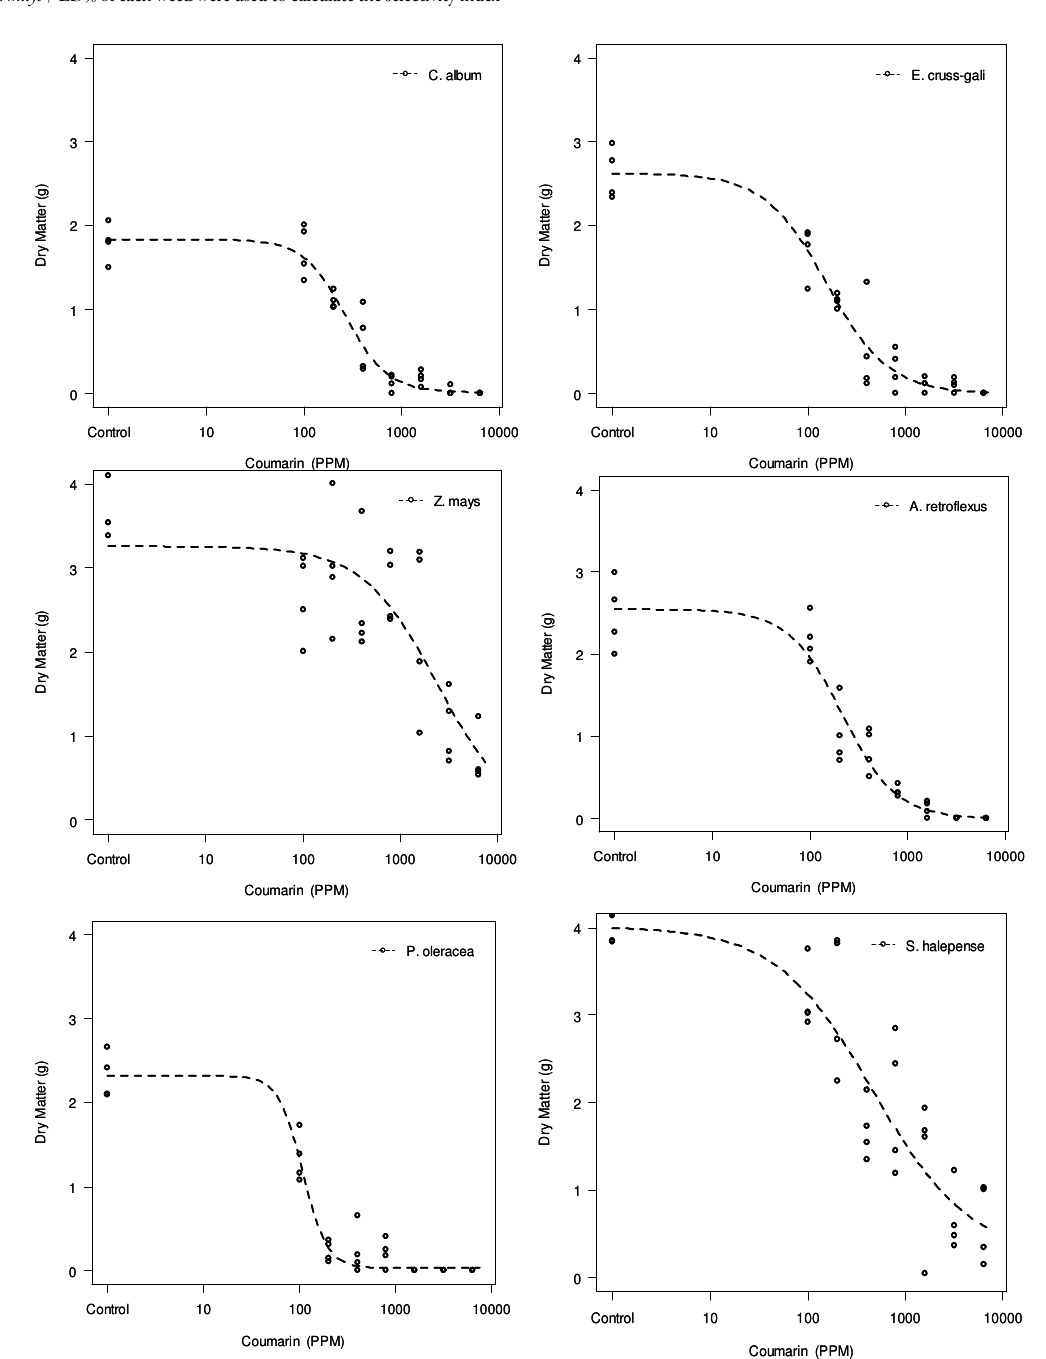
Fig. 1. Dose-response curves of the dry weight of plants on different concentrations of coumarin applied as a pre-plant incorporated into soil. The points are the replications of each